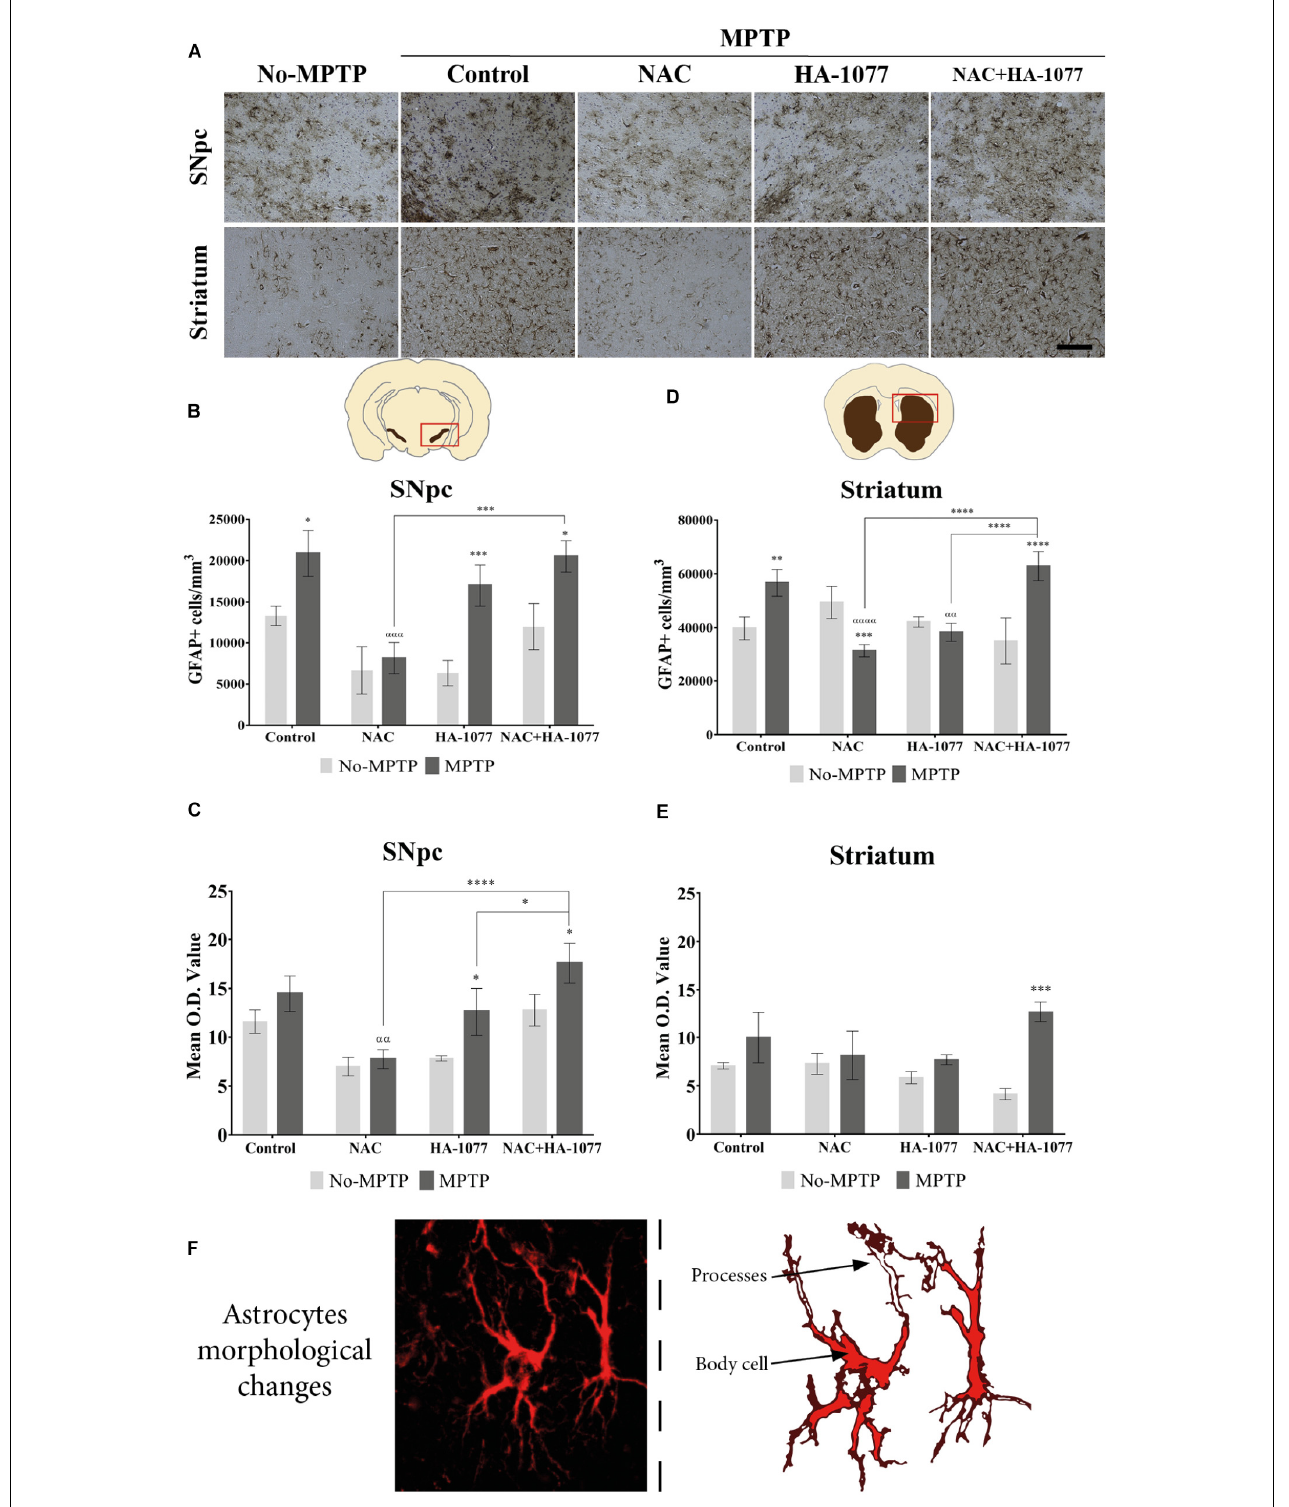
FIGURE 4 | GFAP expression in the SNpc and striatum in brains of old MPTP-intoxicated mice under different treatments. (A) Representative photomicrographs of GFAP immunostaining in the SNpc and striatum (Magnification 20 × , Scale bar = 100 µ m). (B) Quantification of GFAP+ cells/mm 3 in the SNpc. Significant differences were observed in MPTP ( ∗ P = 0.0235), MPTP+HA-1077 ( ∗∗∗ p = 0.0009) and MPTP+NAC+HA-1077 ( ∗ p = 0.0217). MPTP vs. MPTP+NAC ( α = 0.0001)